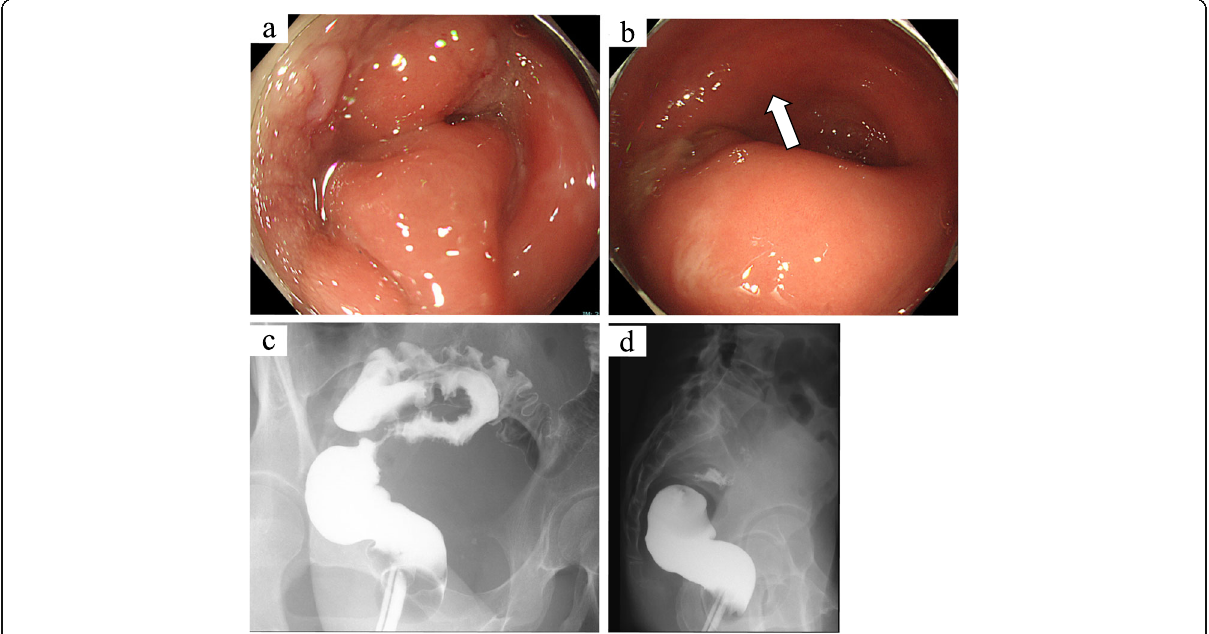
Fig. 1 Colonoscopy and barium enema images. Colonoscopy revealed circumferential stenosis with intact and mucosa. A barium enema revealed a stenosis with a smooth